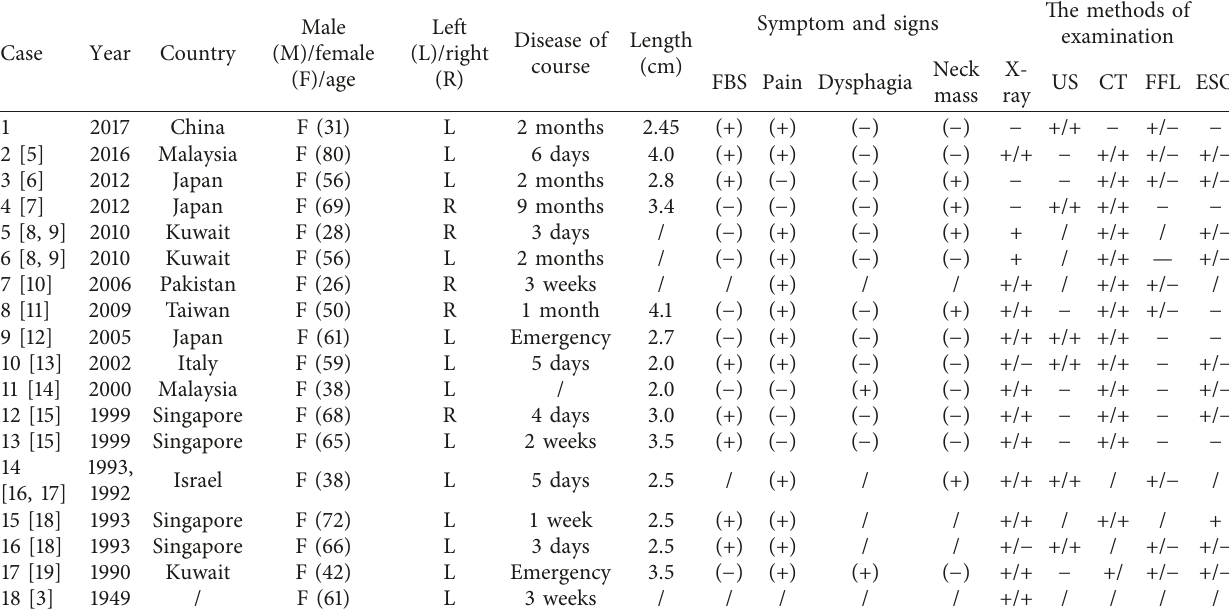
Table 1: The clinical data, diagnosis, and examinations for reported